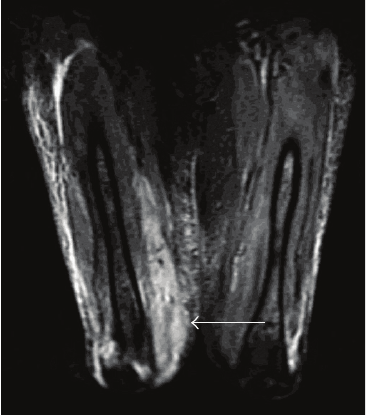
Figure 1: Axial T2-weighted FAT SAT image illustrating diffuse muscle edema involving the lower two-thirds of the anterior com- partment